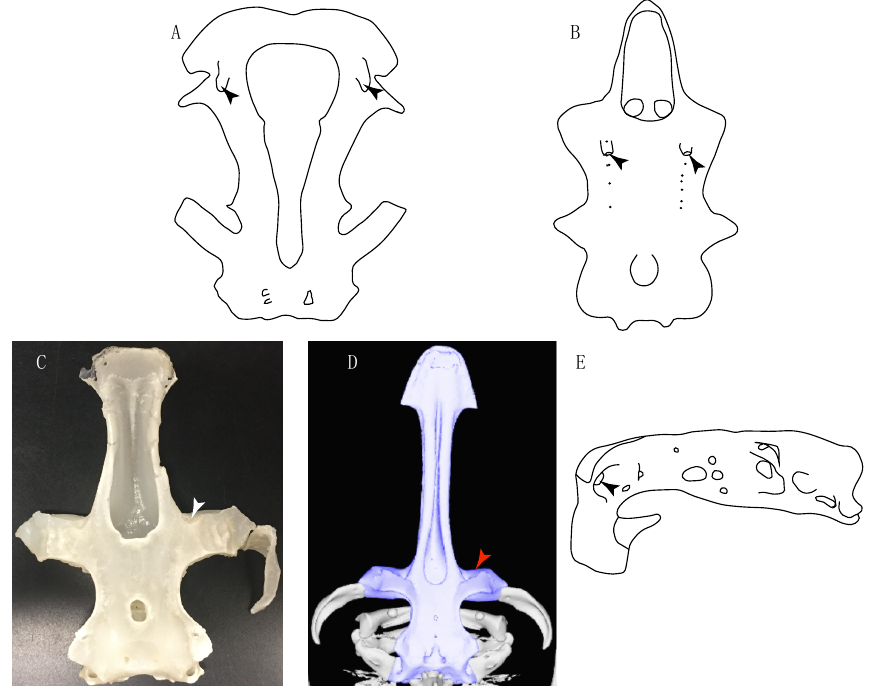
Figure 11. Neurocranium of selected Neoselachii. State (0): ( A ) Potamotrygon mototro (AMNH 97428, https://sharksrays.org/ (23 March 2020)); ( B ) Squalus acanthias based on Thomas et al. Text-Figure 1 in [81]. State (1): ( C ) Zapteryx exasperata (CNPE-IBUNAM 20528); ( D ) Aptychotrema rostrata (CSIRO 101, https://sharksrays.org/ (accessed on 15 May 2020)); ( E ) Myliobatis tobijei based on Nishida Text-